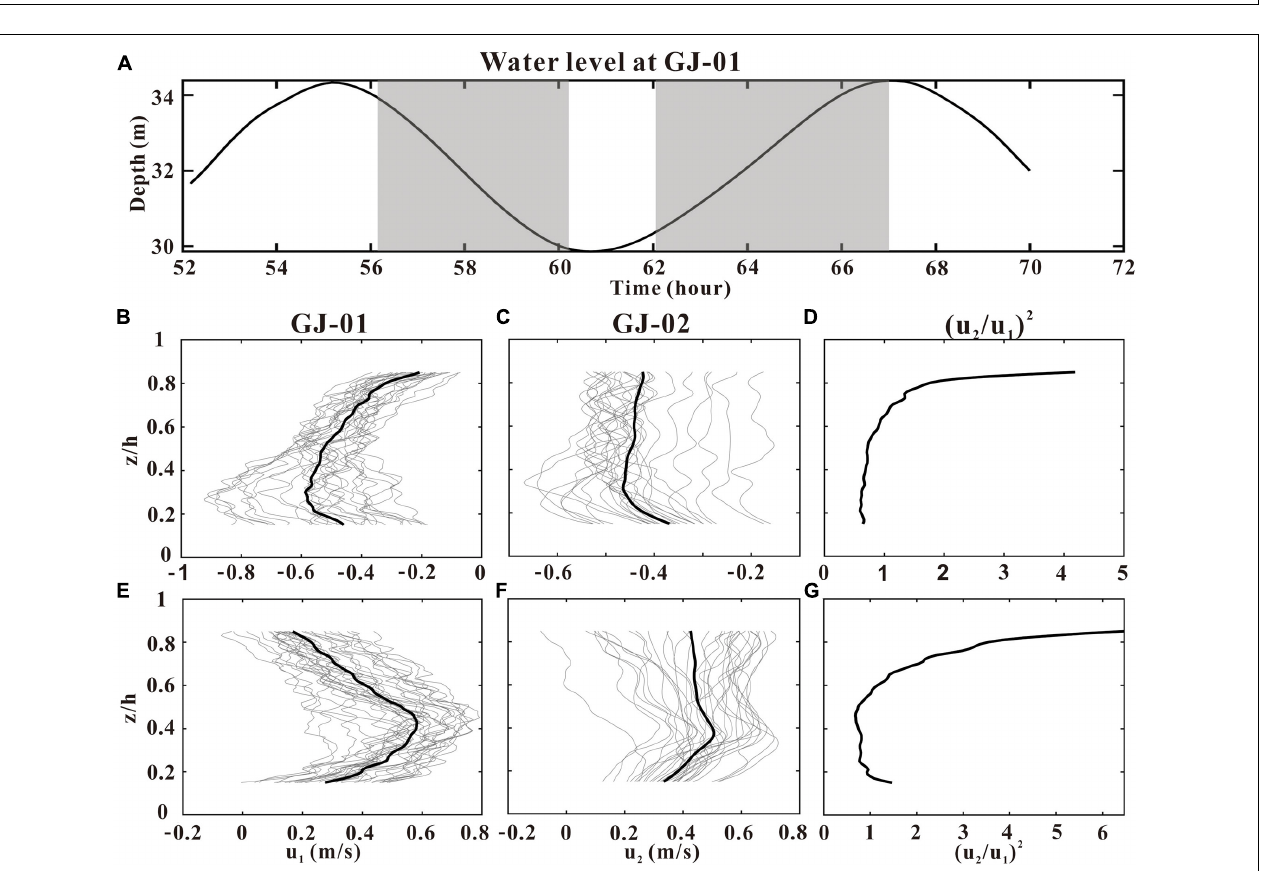
FIGURE 9 | Scatterplots of u s (A) , u b (B) , and the depth-averaged u (C) of GJ-01 vs. GJ-02. The symbols are identical to those in Figure 8 .